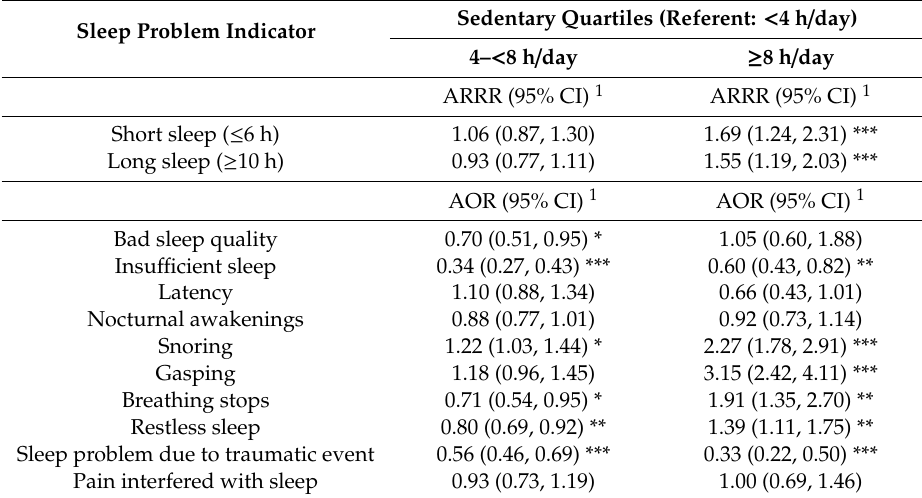
Table 2. Associations of sedentary behaviour with sleep problem